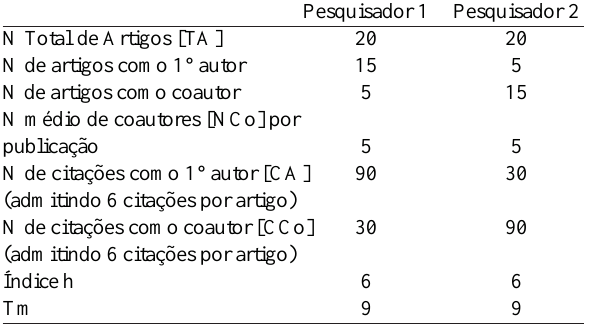
Tabela 2. Indicadores dos pesquisadores 1 e 2.